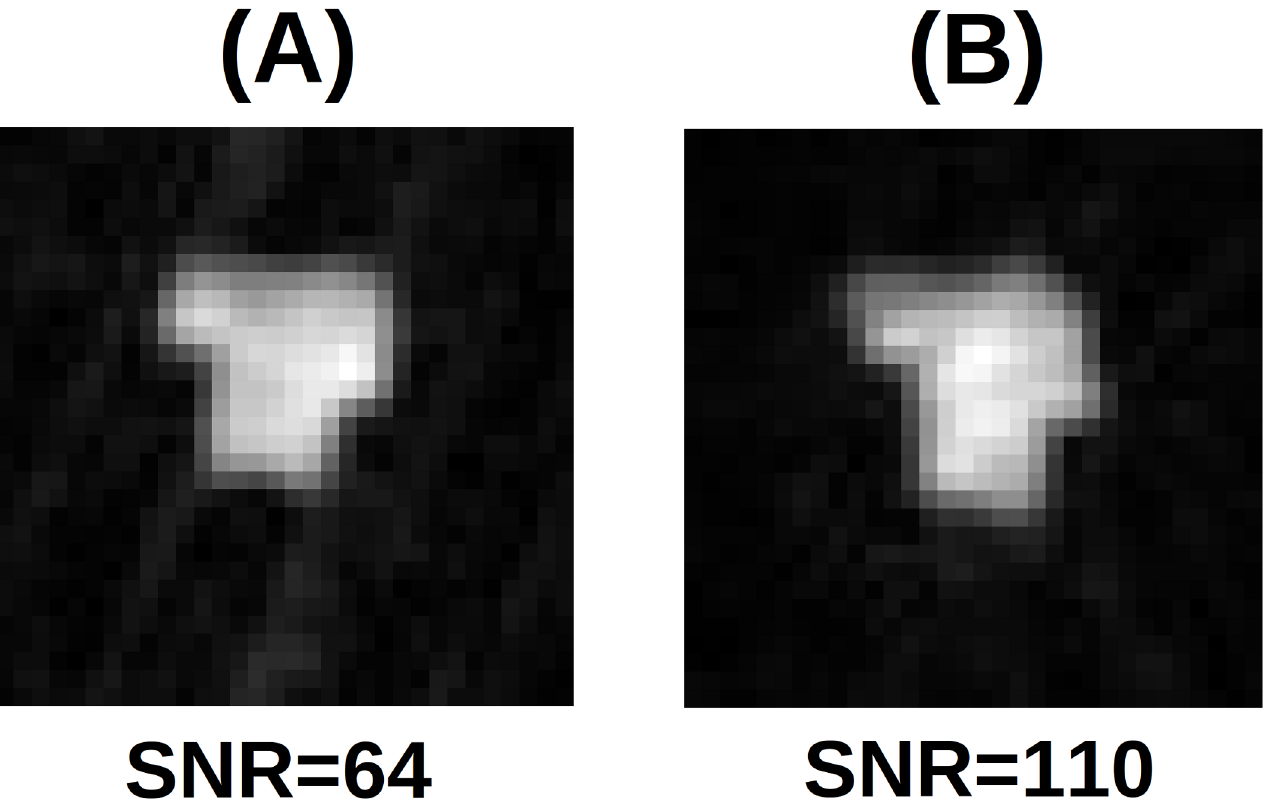
Fig 5. 2D phantom projection (spin echo, T E = 19 ms, T R = 500 ms, NEX = 1, no slice selection) with 3x3 mm 2 resolution: (A) Cartesian (T acq = 16 s) and (B) polar sampling (T acq = 8 s). Cartesian sampling provides lower SNR but less blurring artifacts.